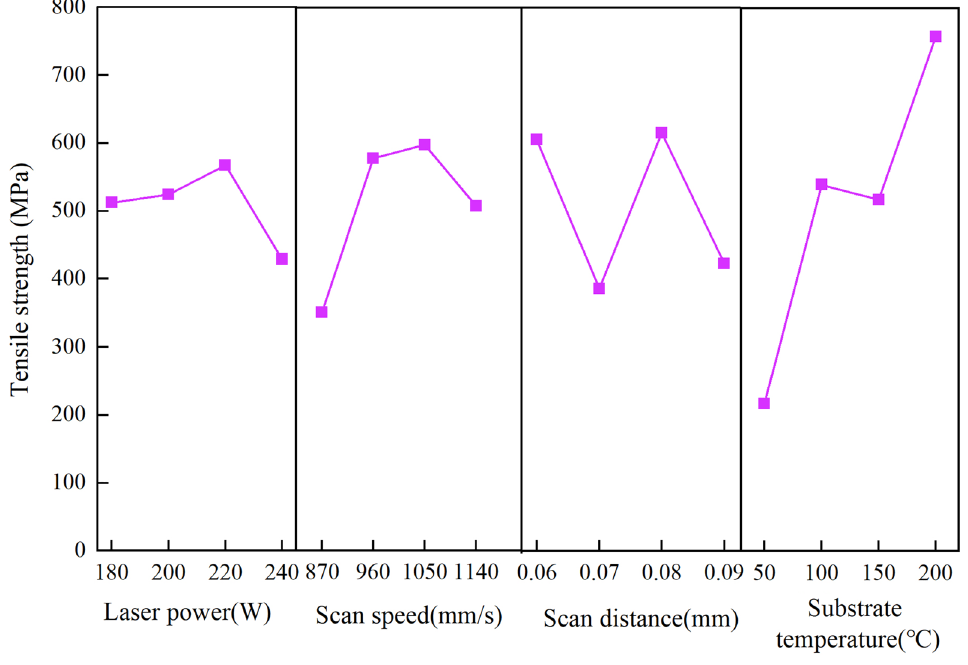
Figure 9 Taguchi experimental curve on strength